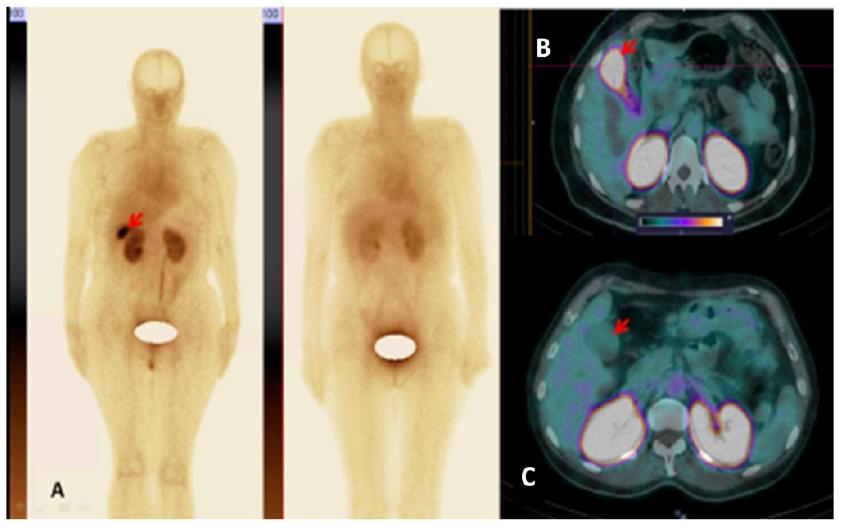
Figure 8. ( A ) Anterior images of female patient 5 (left) and female patient 4 (right) at 2 h after injection of [ 99m Tc]Tc-TG. High [ 99m Tc]Tc-TG uptake in the gallbladder in patient 5 is visualized (arrow). The upper setting of the scale window is 100 % of the maximum counts. ( B ) SPECT/CT image of patient 5 at 2 h after injection of [ 99m Tc]Tc-TG. High [ 99m Tc]Tc-TG uptake (SUVmax = 20.89) in the gallbladder in Patient 5 is visualized (arrow). ( C ) SPECT/CT image of patient 4 at 2 h after injection. There is no pathological uptake in the gallbladder of patient 4 (SUVmax = 2.87) (arrow). The upper setting of the scale window (100% of the maximum number).